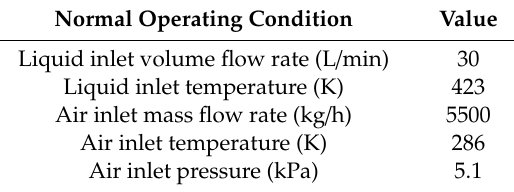
Figure 1. Schematic diagram of annular radiator (AR). Table 1. Normal operating conditions of AR.